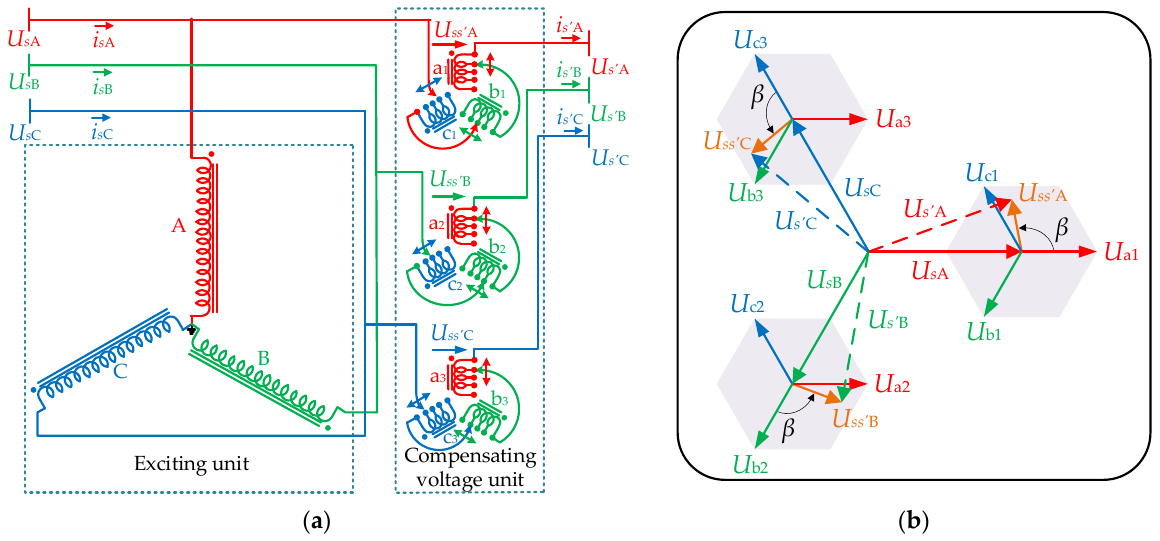
Figure 1. ( a ) The basic topology structure of the ST; ( b ) the vector diagram for the ST’s operation.